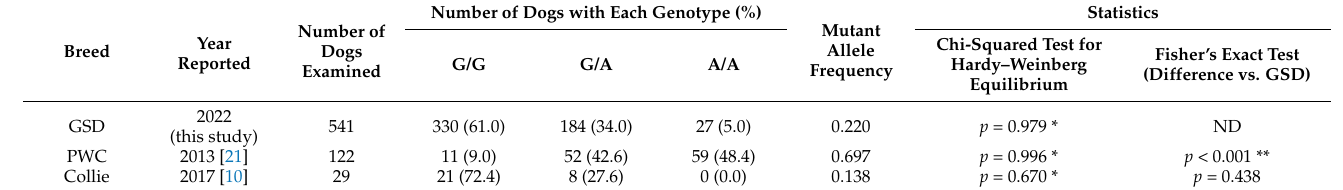
* Chi-squared test analysis ( p ≥ 0.05) indicates that the observed data are in Hardy–Weinberg equilibrium. ** Fisher’s exact test analysis ( p < 0.05) indicates that there is a significant difference versus the mutant allele frequency in the Japanese GSD population. ND: not determined. Table 2. Comparison of the mutant allele frequencies of the degenerative myelopathy-associated mutation ( SOD1 :c.118G>A) in Japanese canine populations of the German Shepherd Dogs (GSDs), Pembroke Welsh Corgis (PWCs), and